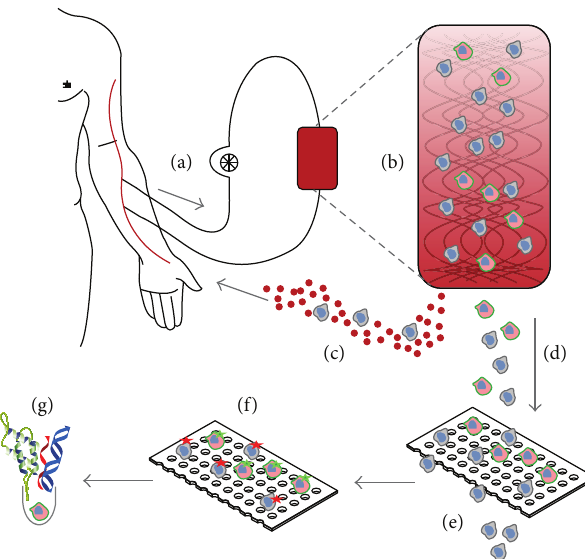
Figure 7: Schematic representation of the CTCTrap. Blood from a patient (a) is passed through a functionalized 3D matrix (b). The porous matrix can withstand up to 5 L of blood flow. In this matrix are one or more specific antibodies present for CTC capture. A continuous blood flow without cells of interest is circled back to the patient (c). Retained cells are eluted from the matrix (d) and will be filtered through 1–5 𝜇 m pores to reduce hematopoietic background (e). Cells retained on the filter can be used for immunofluorescent staining to discriminate CTC from non-CTC (f) and subsequently be used for isolation of single CTC for additional molecular characterization, like protein, RNA, and DNA analysis